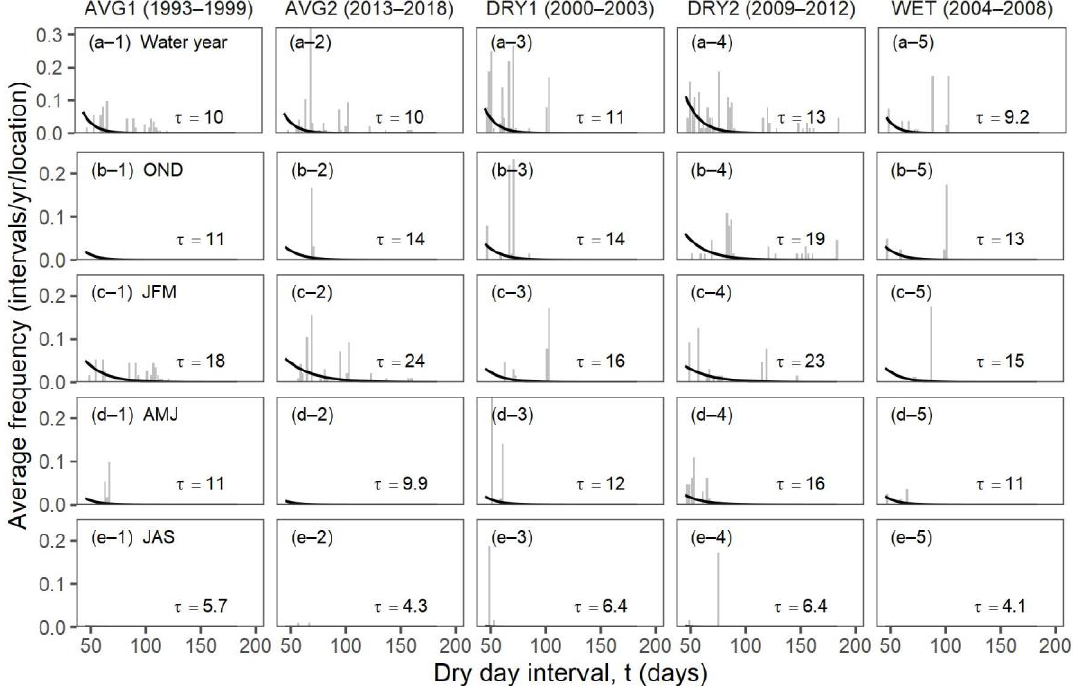
Figure 6. As in Figure 5 except for dry-day intervals ≥ 45 days. Vertical scale differs by row. Differences in precipitation between periods were further distinguished by compar- ing storm depth ( α ) and dry-day interval ( τ ) parameters with patterns in species richness of functional groups. In fall (OND) and spring (AMJ), AVG1 had a larger mean storm depth and a smaller mean dry-day interval than AVG2 with more C 3 species in AVG1 for all locations (Figures 2 and 7a,c). Mean storm depths in spring (JFM) and summer (JAS) were not significantly different for these two periods. On the other hand, while the differ- ence between dry-day intervals between AVG1 ( τ =5.7 days) and AVG2 ( τ = 4.3 days) in summer (JAS) was small (Figure 7c), the AVG1 dry-day interval was 32% larger than AVG2.